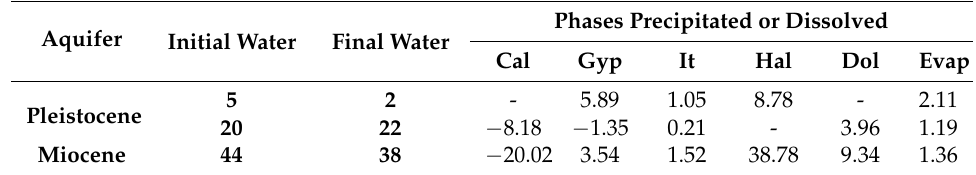
Table 3. NETPATH water-rock interaction model results (mmol/L) representing groundwater Group